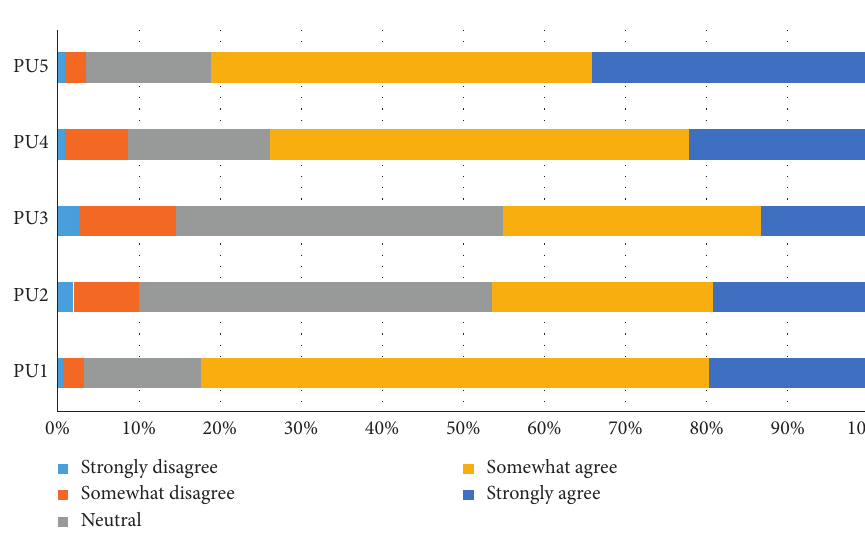
Figure 2: Percentage of perceived usefulness of Robo-taxis.